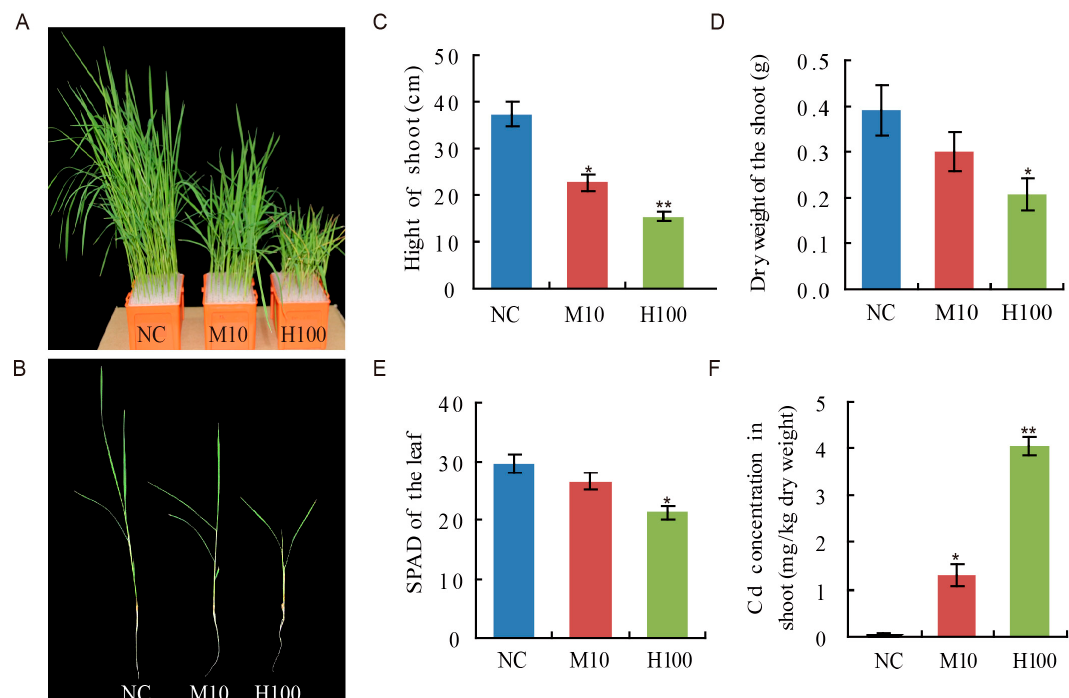
Figure 1. The morphology of the rice seedling shoot and its Cd content when grown hydroponically for 12 days in a solution containing 0 μΜ (NC), 10 (M10) μΜ or 100 μΜ (H100) Cd 2+ . ( A , B ) The appearance of the seedlings; ( C ) the effect on shoot height; ( D ) the effect on dry matter accumulation; ( E ) the effect on the leaf chlorophyll content (soil and plant analyzer development, SPAD) after 12 days of Cd 2+ treatment; ( F ) the effect on tissue Cd content. Values in ( C – F ) are means ± SD ( n = 3); the asterisks indicate statistical significance between the M10, H100 and NC, as determined by a Student’s t -test (* p ≤ 0.05; ** p ≤ 0.01).